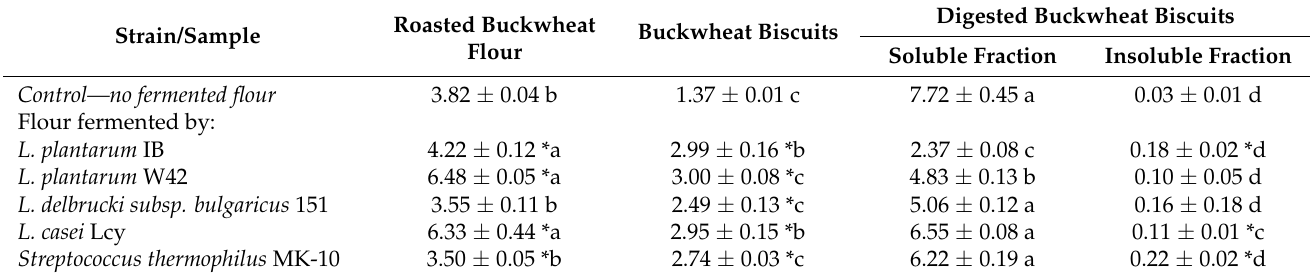
Table 4. The content of quercetin (Q) in fermented roasted buckwheat flours and buckwheat biscuits before and after digestion in vitro ( µ g g − 1